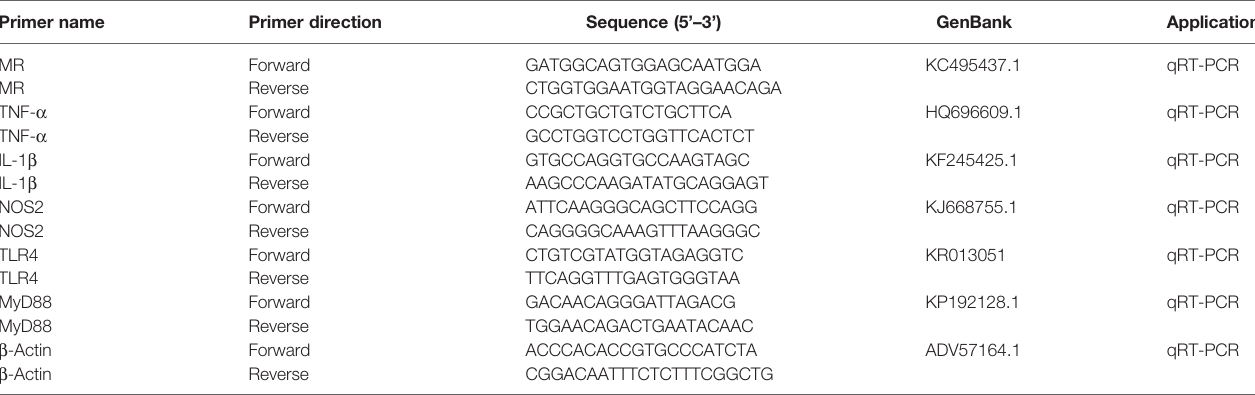
TABLE 1 | Primers used in this